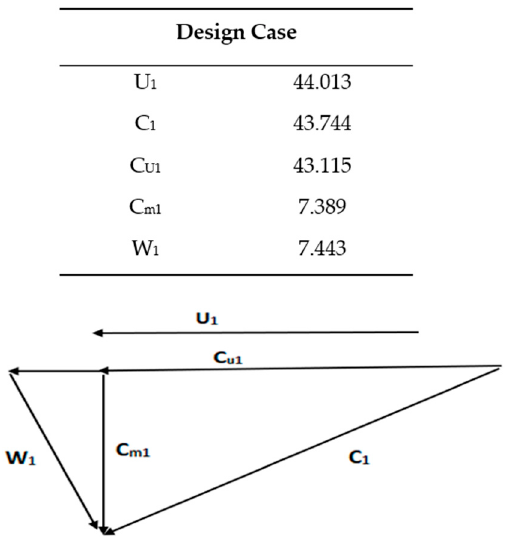
Figure 4. ( a ) Rotating disc apparatus (RDA) apparatus; ( b ) apparatus components; ( c ) erosion behavior observed on the blade [13].